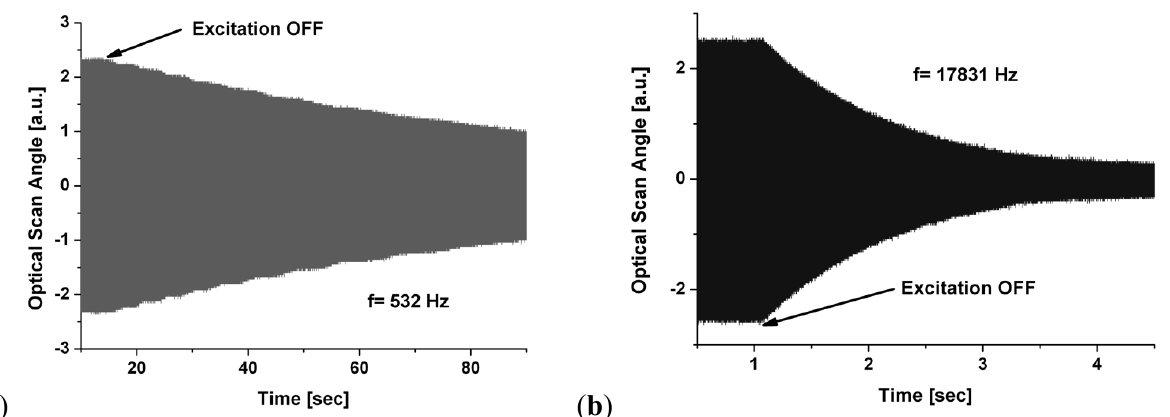
Figure 16. Amplitude decay over time of gimbal ( a ) and mirror ( b ).